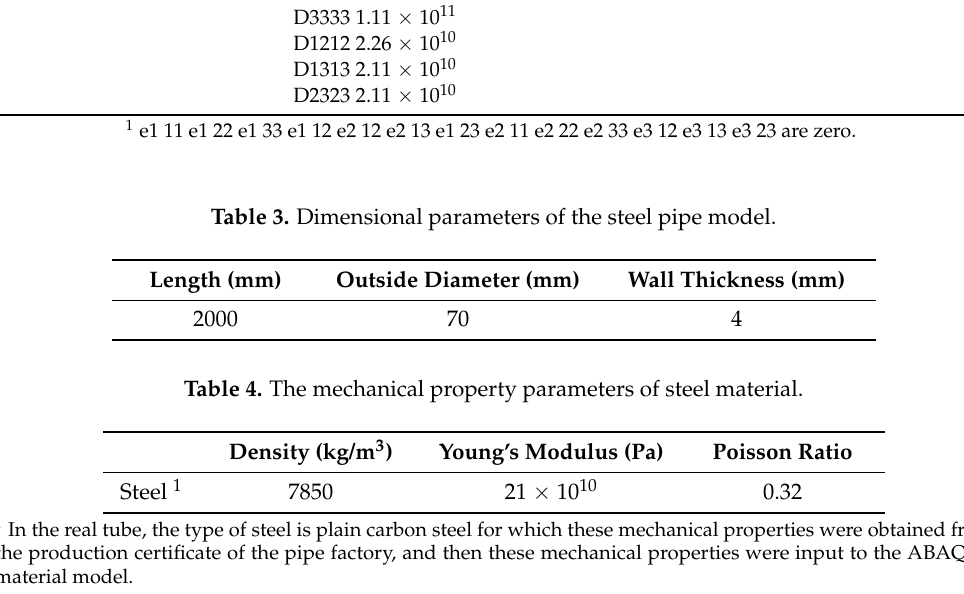
Table 3. Dimensional parameters of the steel pipe model.